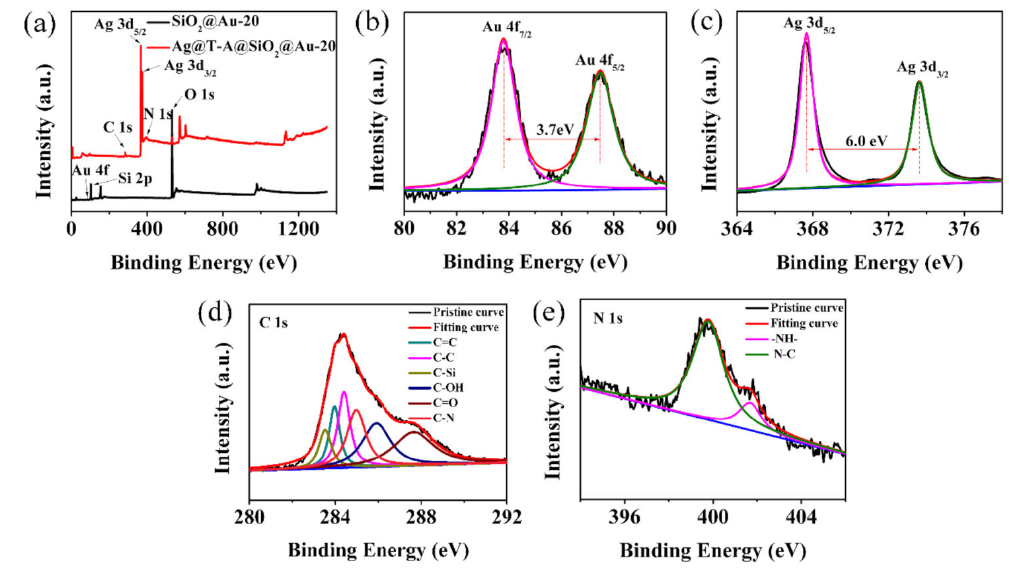
Figure 5. XPS full spectra of SiO 2 @Au-20 and Ag@T-A@SiO 2 @Au-20 nanofibers ( a ), the divided peak spectra of Au ( b ), Ag ( c ), C ( d ), and N ( e ) elements.